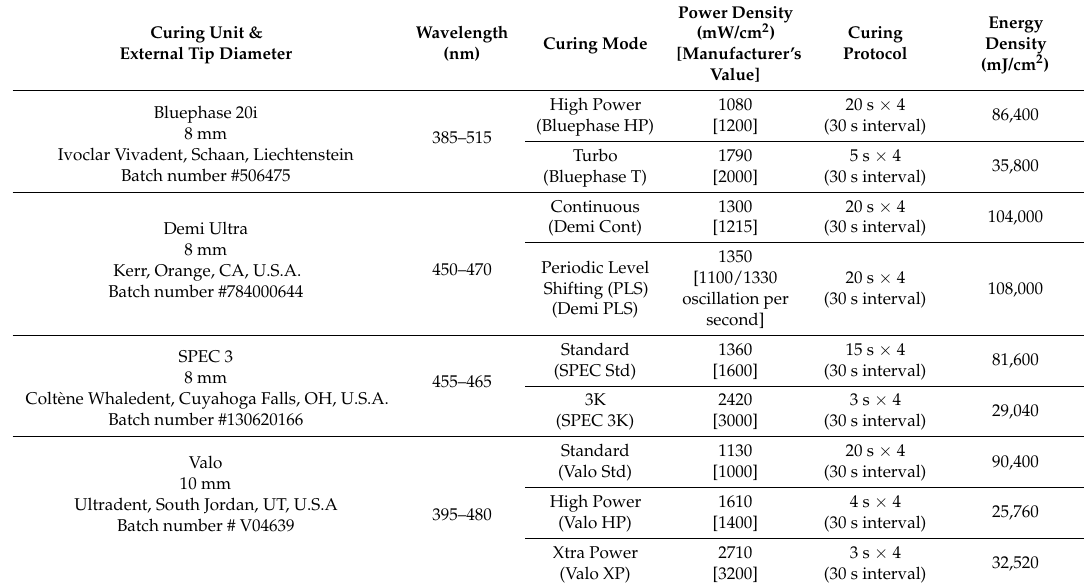
Table 3. LED light curing unit characterization: wavelength range, curing modes and protocol, estimated irradiance, and delivered energy